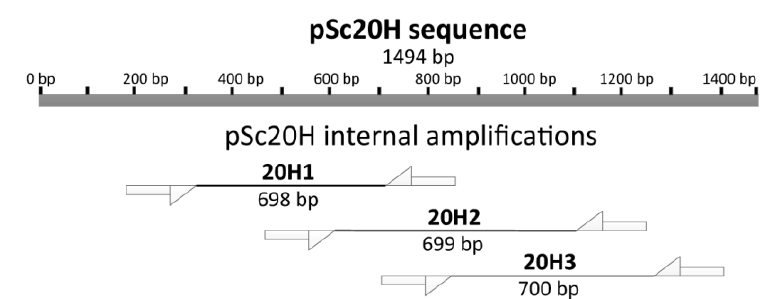
Figure 2. Dimensions (bp) of fragments expected from the amplification of three internal segments of pSc20H (accession number AF305943): 20H1, 20H2, and